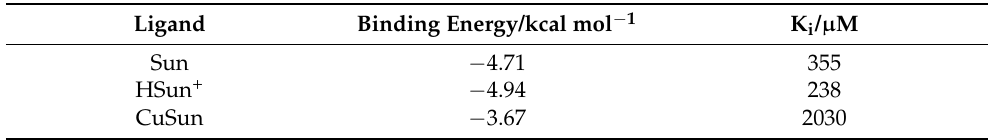
Figure 4. Left: Most favorable binding mode in the ATP binding pocket of the tyrosine kinase domain of VEGFR2 for ( a ) HSun + and ( b ) CuSun. Right: Residues that interact with the ligand, through close contacts or through hydrogen bonds (shown as green dots) for ( a ) HSun + and ( b ) CuSun. Table 4. Binding energies (kcal mol − 1 ) and inhibition constants (K i , µ M) for the lowest energy conformations obtained by molecular docking, with VEGFR2 as rigid receptor and Sun, HSun + and the CuSun complex as